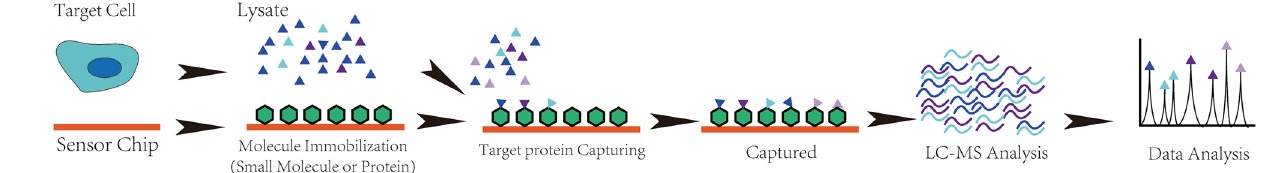
Figure 1. The diagrams of process and mechanism of the SPR, HPLC and